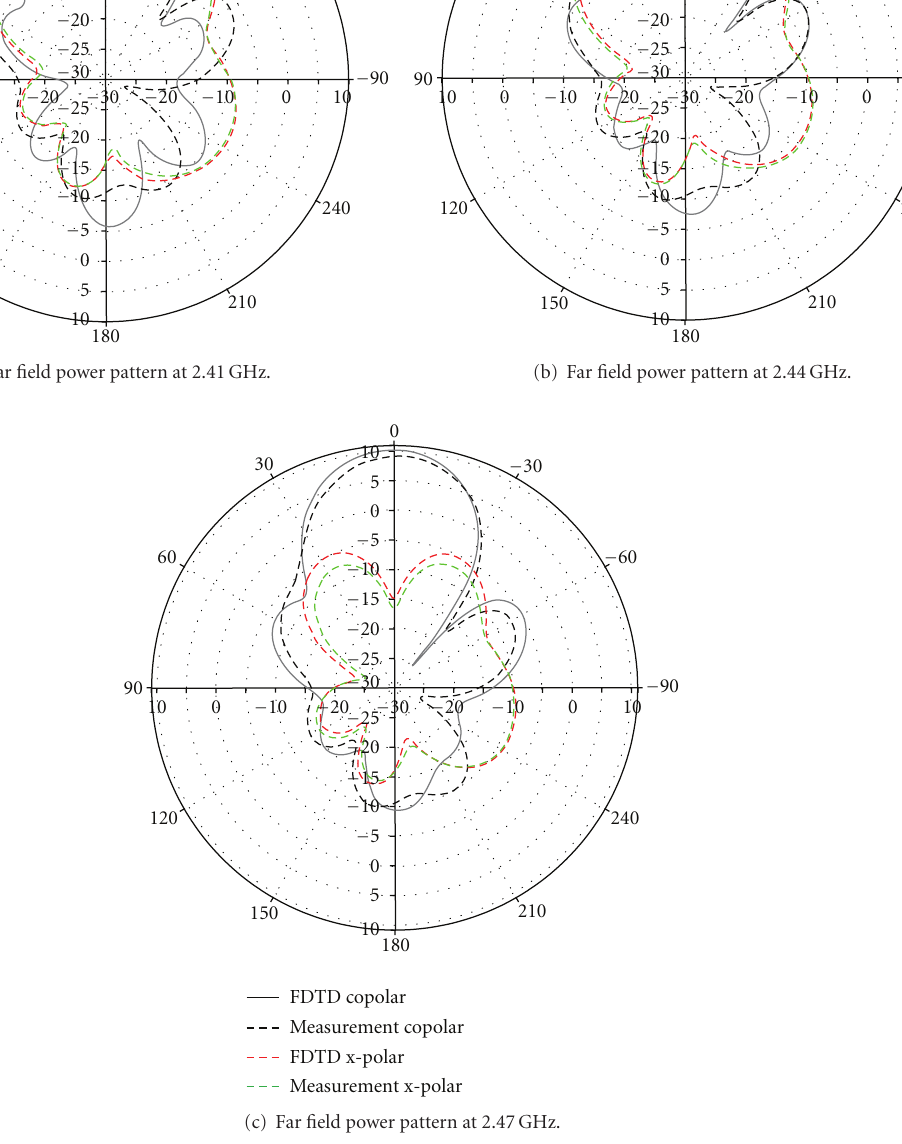
dramatically improves the computing e ffi ciency without any extra hardware investment and provides an e ffi cient and economical technique for the electromagnetic